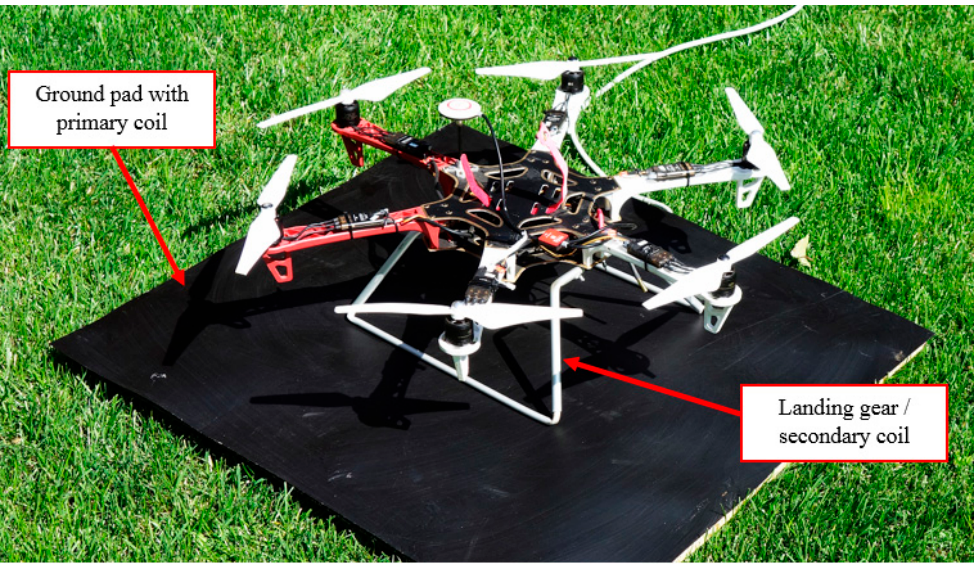
Figure 17. WPT demonstrator with aluminum landing gear applied to the DJI F550 drone.